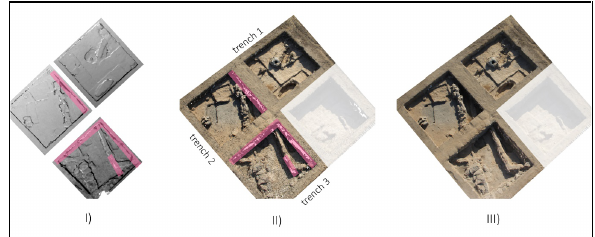
Figure 14 . The presence of holes, deformations and gaps (marked in pink) in the vertical slopes of the archaeological trenches in (I) monochromatic rendering of the “difference image” resulting from the 3D model comparison (4/7/2019) between laser scanner and aerial DSLR Canon EOS 1200D, (II) the dense cloud and (III) the textured model in AgiSoft PhotoScan software of the 3 archaeological trenches.